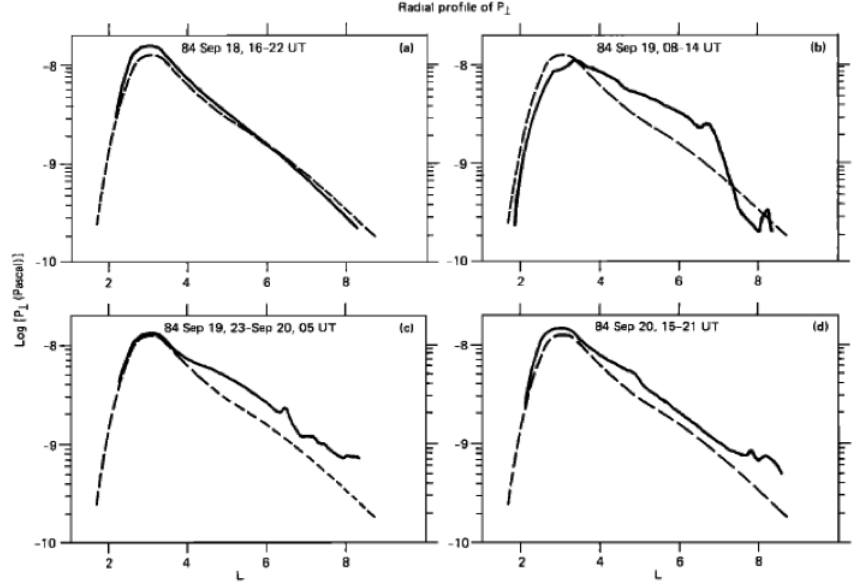
Figure 1. The radial profiles of the particle pressure perpendicular to the magnetic field from four consecutive passes of AMPTE spacecraft during the 18–20 September 1984 storm (Fig. 6 from Lui et al., 1987).